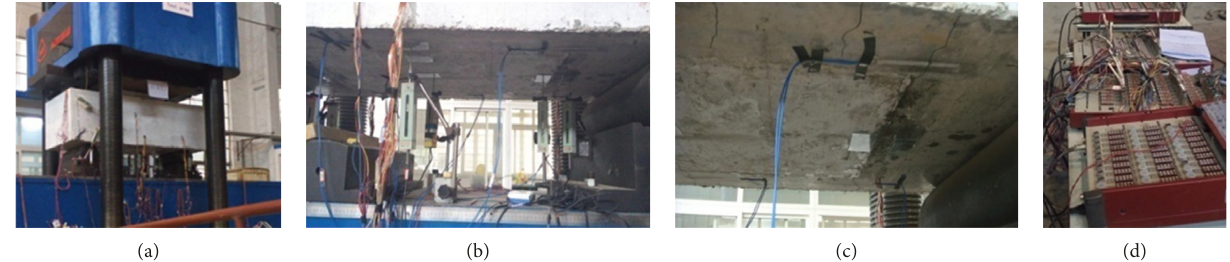
Figure 5: (a) Loading device; (b) displacement meters; (c) strain gauges; (d) static data acquisition system.